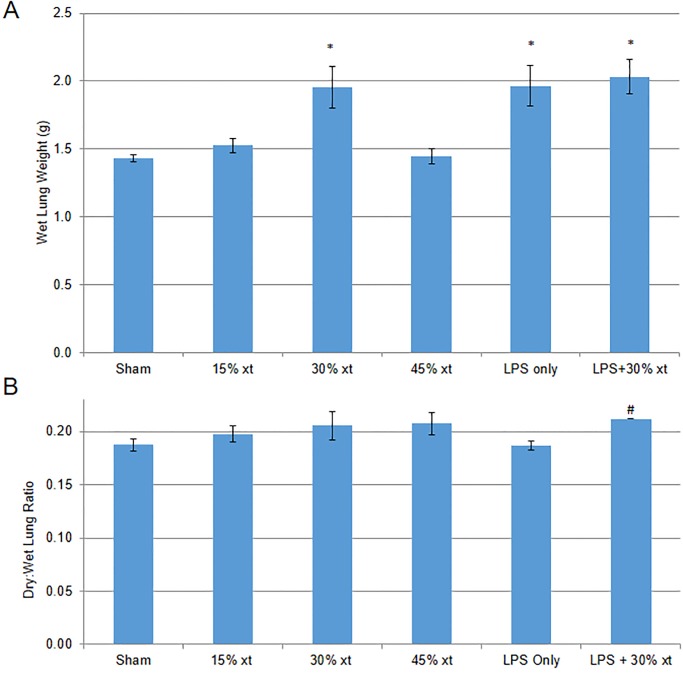
Thirty percent erythrocyte transfusion with LPS treatment increases lung weight.(A) Gross lung weights measured for sham animals (n = 6), rats receiving 15 (n = 3), 30 (n = 6) or 45% (n = 3) human erythrocyte transfusion (xt), LPS only (n = 7) or LPS+30% (n = 11) transfusion. (B) Wet and dry weights measured for sham animals (n = 8), rats transfused with 15 (n = 2), 30 (n = 3) or 45% (n = 3) human erythrocyte transfusion (xt), LPS only (n = 3) or LPS+30% (n = 3) transfusion and expressed as dry to wet ratio. Data are means and standard error of the mean. Statistical analysis was performed using an ANOVA followed by Student t-test. * denotes P < 0.01 compared to the sham. # denotes P < 0.05 compared to LPS only.